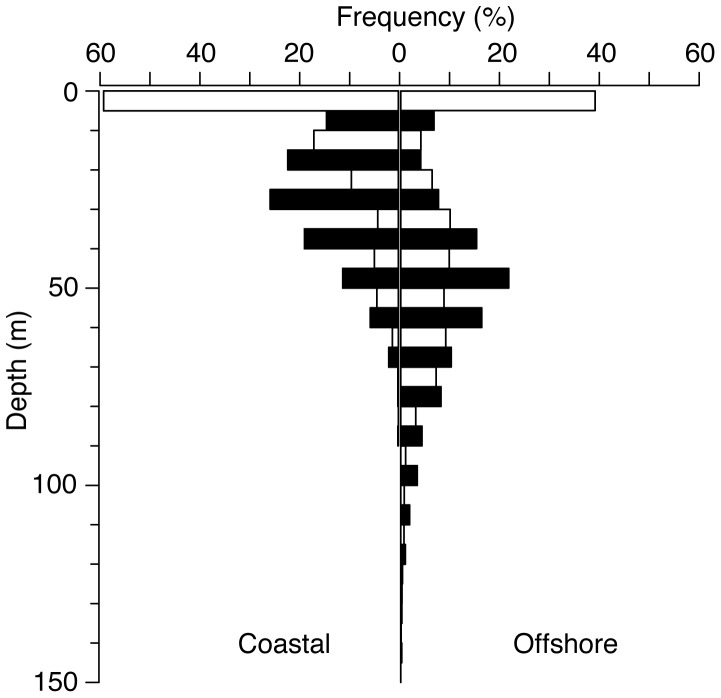
Coastal and offshore depth occupation.Frequency histogram comparing coastal (left) and offshore (right) depth occupation over a diel cycle. Bars are in 10 m bins. White and black bars indicate day and night, respectively.